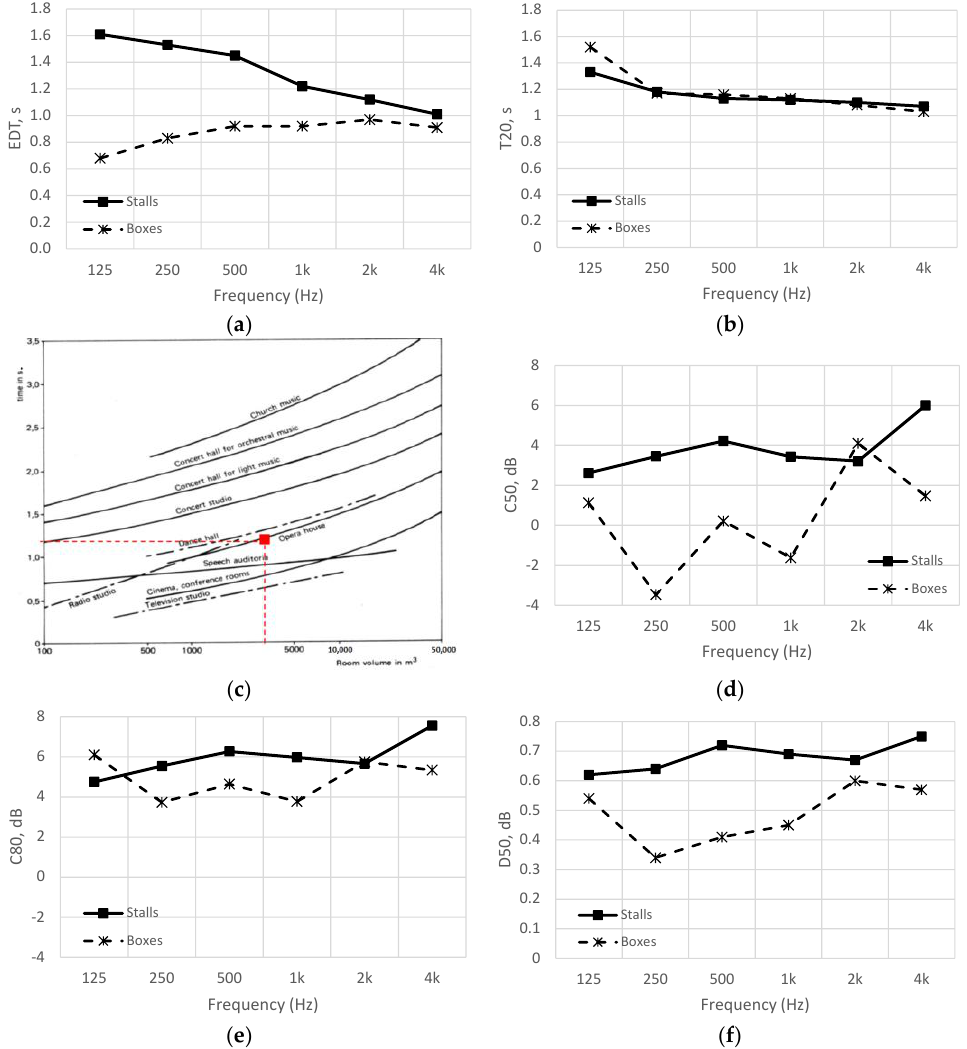
Figure 6. Measured results of the main acoustic parameters: EDT ( a ), T 20 ( b ), C 50 ( d ), C 80 ( e ), and D 50 ( f ). Correlation between reverberation time and volume size of the theater ( c ).